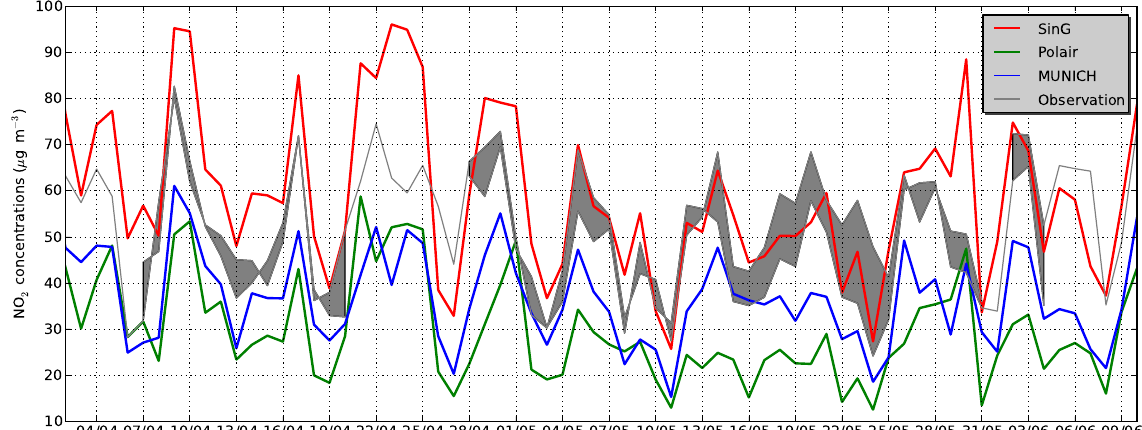
Figure 7. Temporal evolution of NO 2 daily-averaged concentrations modeled with MUNICH (blue line), Polair3D (green line), and the SinG model (red line). They are compared to the measured concentrations (gray shaded regions) at the stations nearby traffic on each sidewalk of the Boulevard Alsace-Lorraine. If the measurement is available at only one station, a black line is used